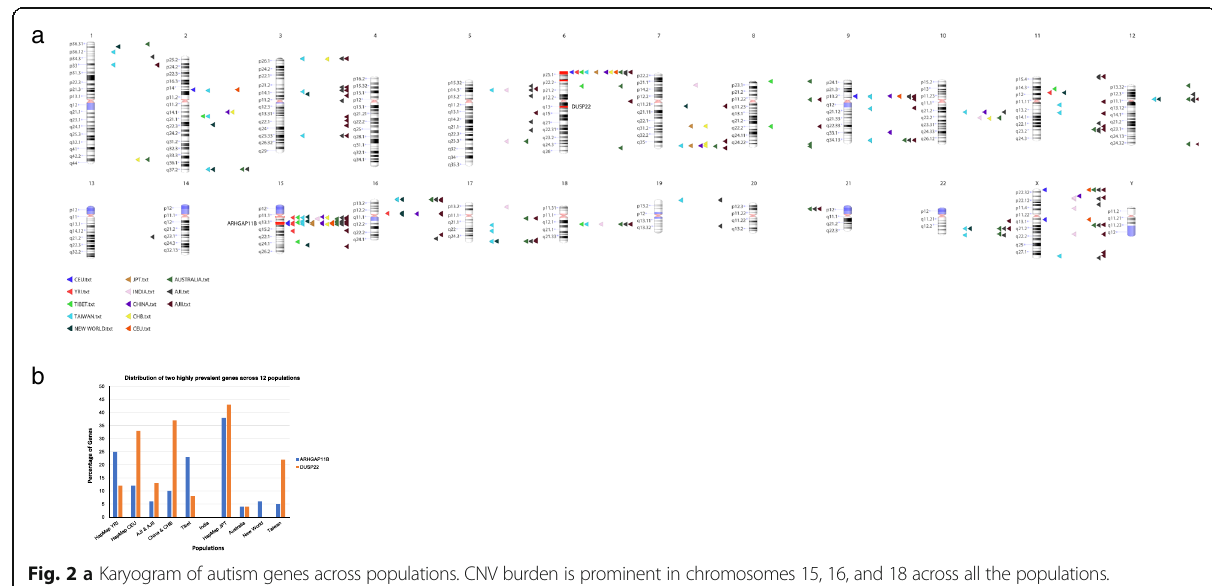
Fig. 2 a Karyogram of autism genes across populations. CNV burden is prominent in chromosomes 15, 16, and 18 across all the populations. Chromosome 15 has many CNV regions catering to the CNV burden. HapMap China, Tibetan and Ashkenazi Jews samples show specific CNV loci positioned at 2q21.1, 19p13, 20p11 and 13q14, respectively. The distribution of CNVs in sex chromosome varies in all the populations except for HapMap YRI and Tibetan populations where CNVs are absent. CNVs are absent in chromosomes 4, 14, 21, and Y. b Percentage of the top two prevalent autism genes: DUSP22 and ARHGAP11B across populations. HapMap JPT has the highest percentage of both the genes, while India has the least